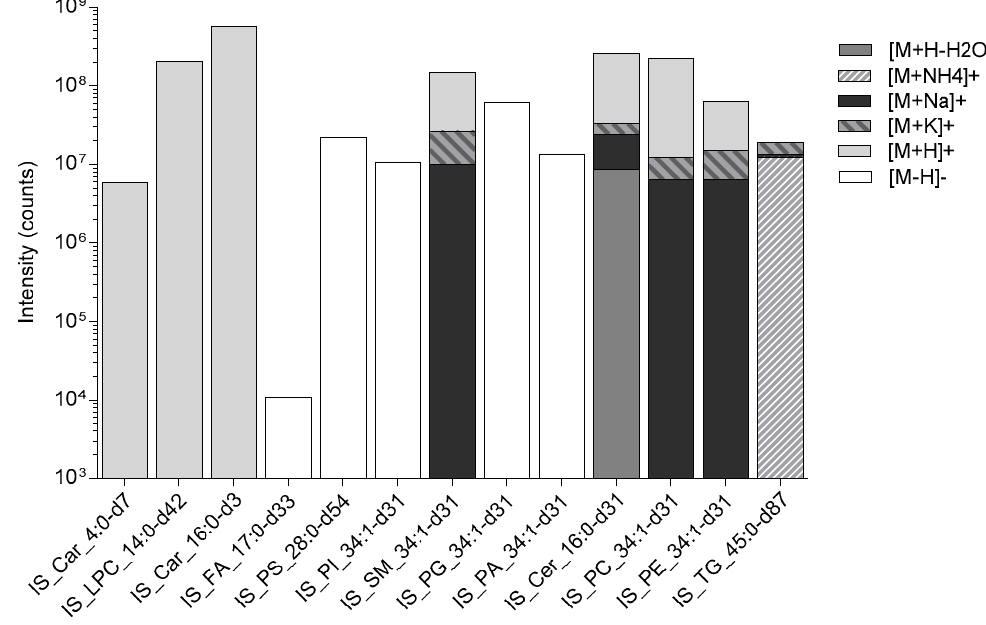
Figure 5. This figure shows the intensity of the extracted ion chromatogram for each stable isotope ‐ labelled internal standard along with the ionisation adduct composition: [M+H] + , [M+H ‐ H2O] +